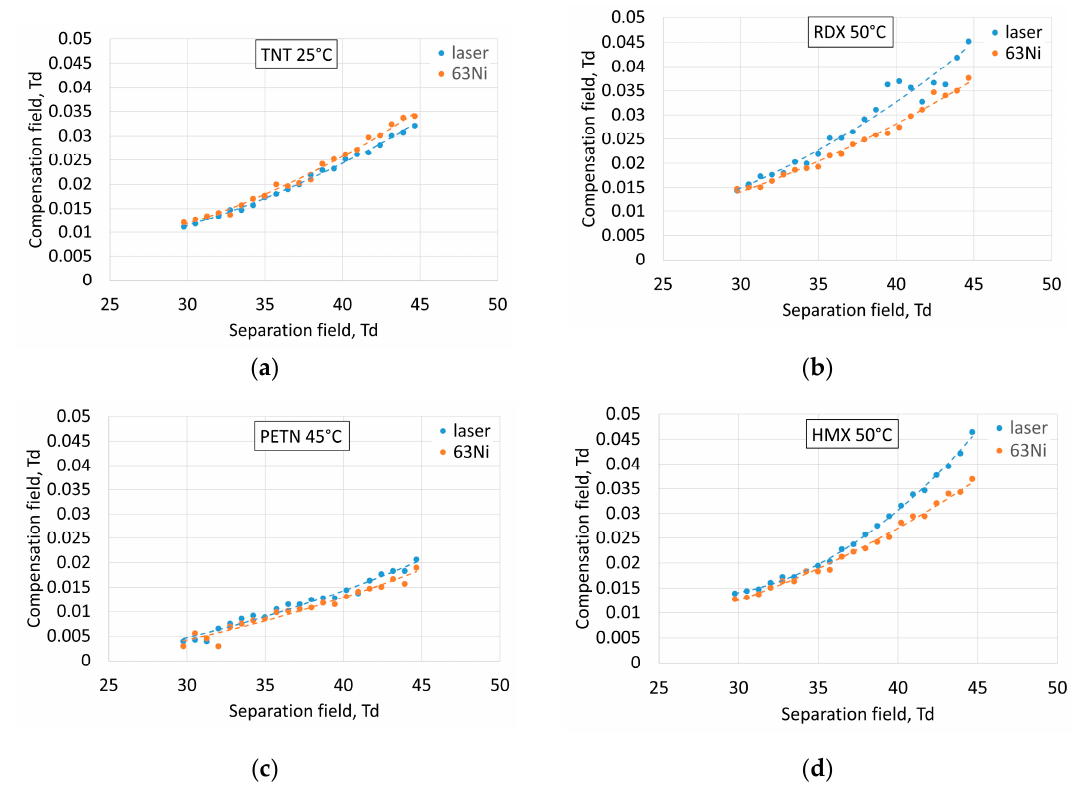
Figure 3. Comparison of ion peak positions at separation field variation from laser at I = 3.5 × 10 7 W/cm 2 and 63 Ni ionization: ( a ) TNT at 25 °C; ( b ) RDX at 50 °C; ( c ) PETN at 45 °C; ( d ) HMX at 50 °C. Рис .3.